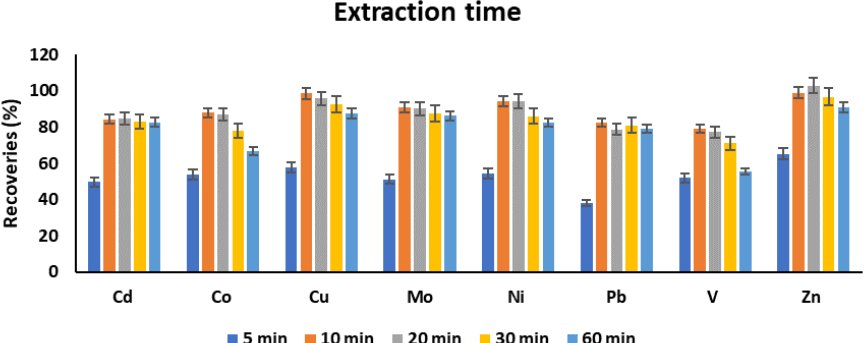
Figure 6. The effect of extraction time on the recoveries of target metals. Experimental conditions: sample pH: 4.5, volume of complexing reagent: 200 µL, volume of extraction solvent: 7.5 mL, extraction solvent: chloroform.